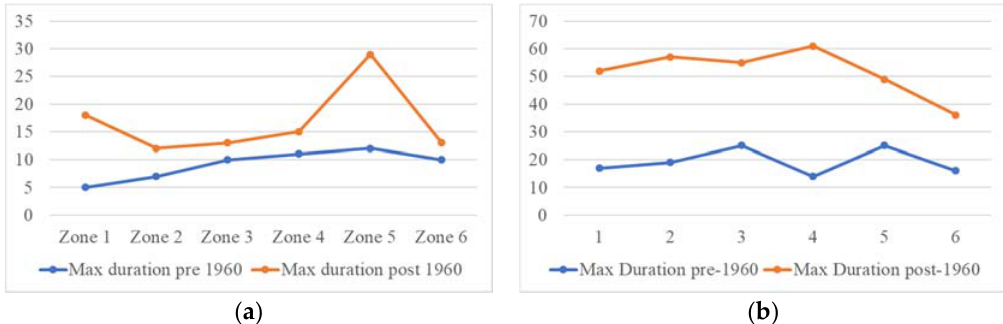
Figure 16. ( a ) 3 ‐ month and ( b ) 12 ‐ month SPEI maximum drought duration.